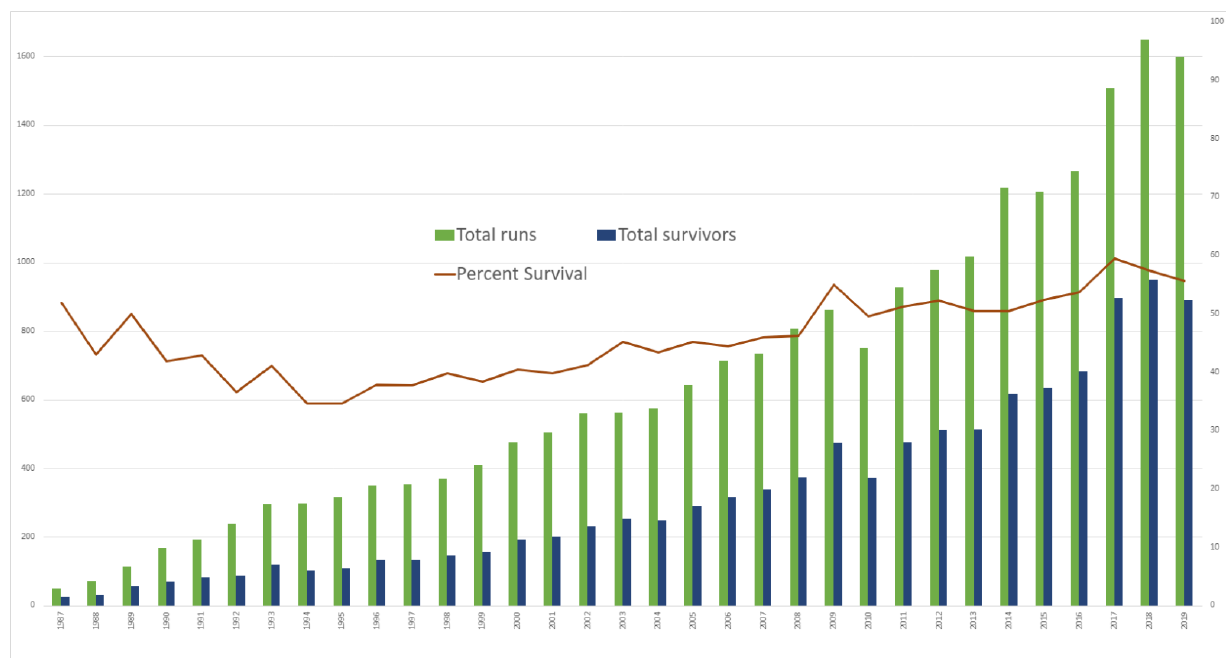
Figure 1. Number of neonatal and pediatric VA ECMO runs per year with percent survival. Adapted from the ELSO Registry International Summary [4].